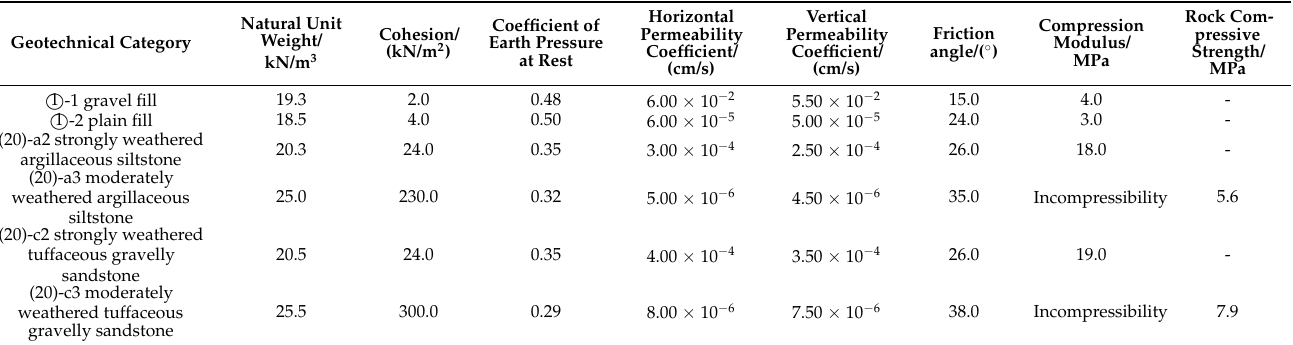
Table 1. Soil parameters.